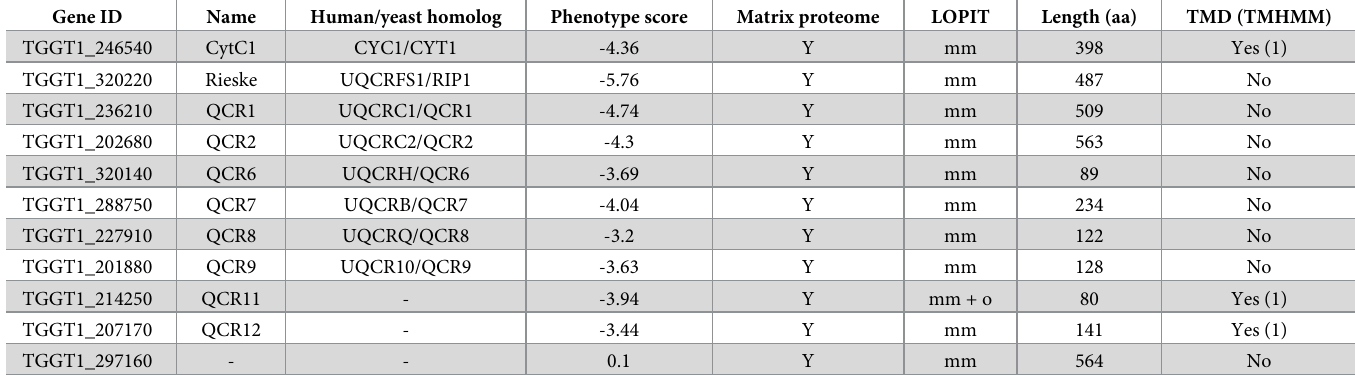
Table 2. Details of nuclear encoded complex III subunits. Phenotype scores were taken from Sidik et al., 2016 [56]; Matrix proteome from Seidi et al., 2018 [7]; (Y–pres- ent in proteome, N–absent); LOPIT from Barylyuk et al., 2020 [36] (mm–mitochondrial membrane, N/A–not identified in dataset). TMD: Transmembrane domain, pre- dicted by TMHMM server. TGGT1_297160 was initially identified as a potential complex III subunit but was later